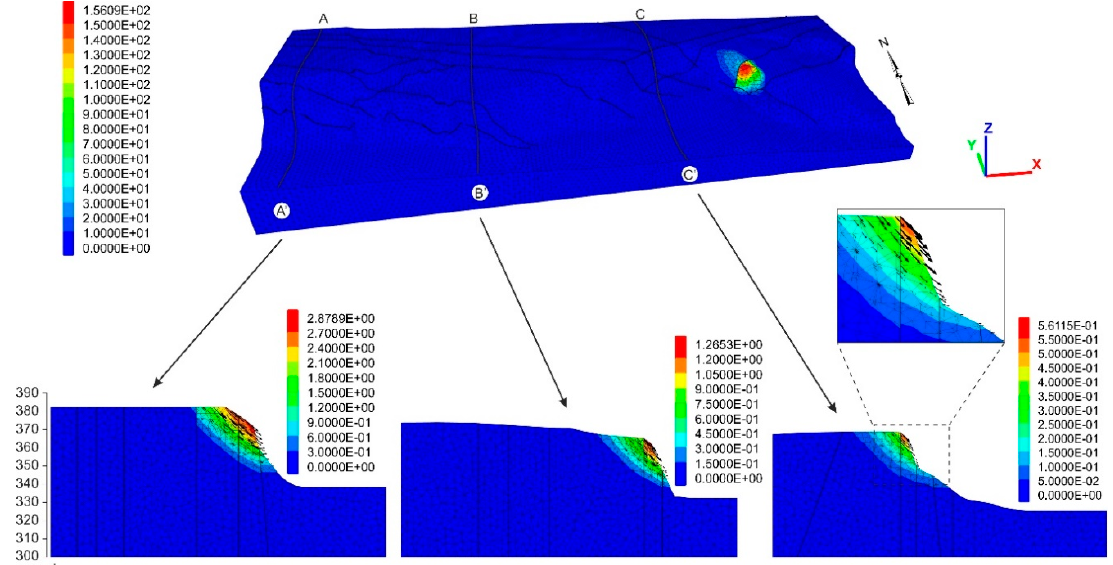
Figure 23. Contour displacement and displacement vectors (sections) of the post-landslide model with discontinuities.